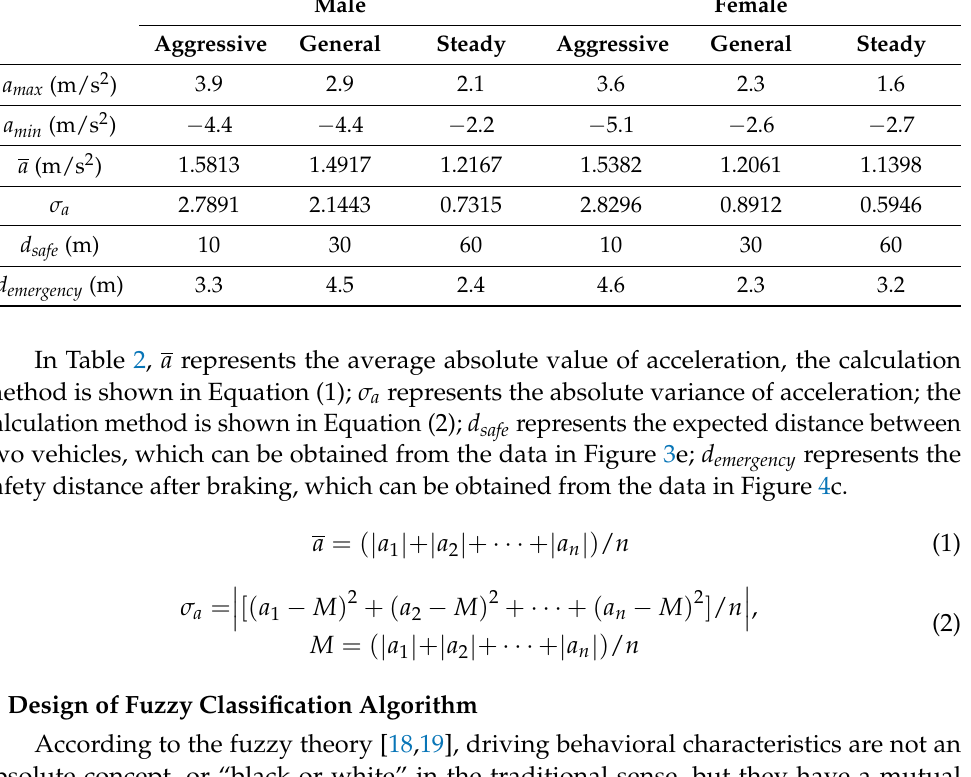
Table 2. An experimental data analysis table of driving behavioral characteristics. Male Female Aggressive General Steady Aggressive General Steady a max (m/s 2